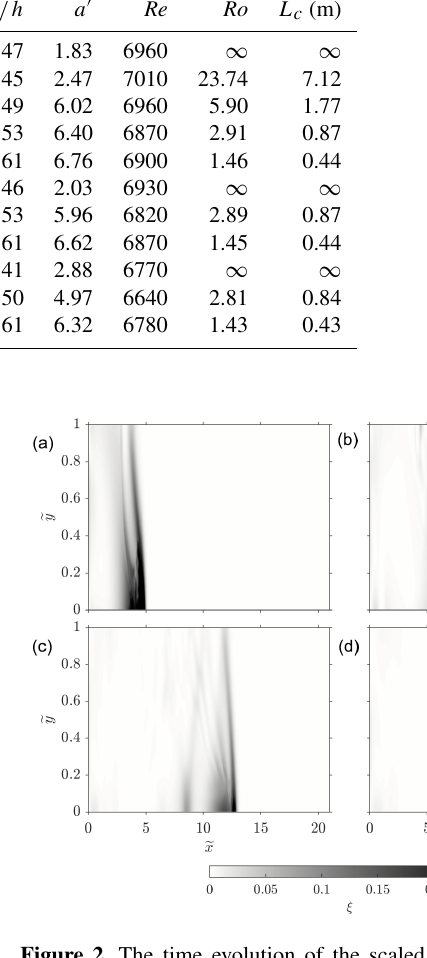
Figure 2. The time evolution of the scaled, vertically integrated kinetic energy, ξ , for case 10_1 at (a) e t = 2 . 6 (t = 25s ) , (b) e t = 5 . 2 (t = 50s ) , (c) e t = 7 . 8 (t = 75s ) , and (d) e t = 10 . 4 (t = 100s ) . The colour axis is saturated at early times to show the wave at later